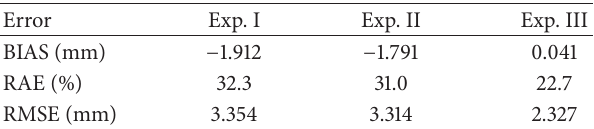
Table 3: Error analysis of stations with tropical rain in the June– August 2010